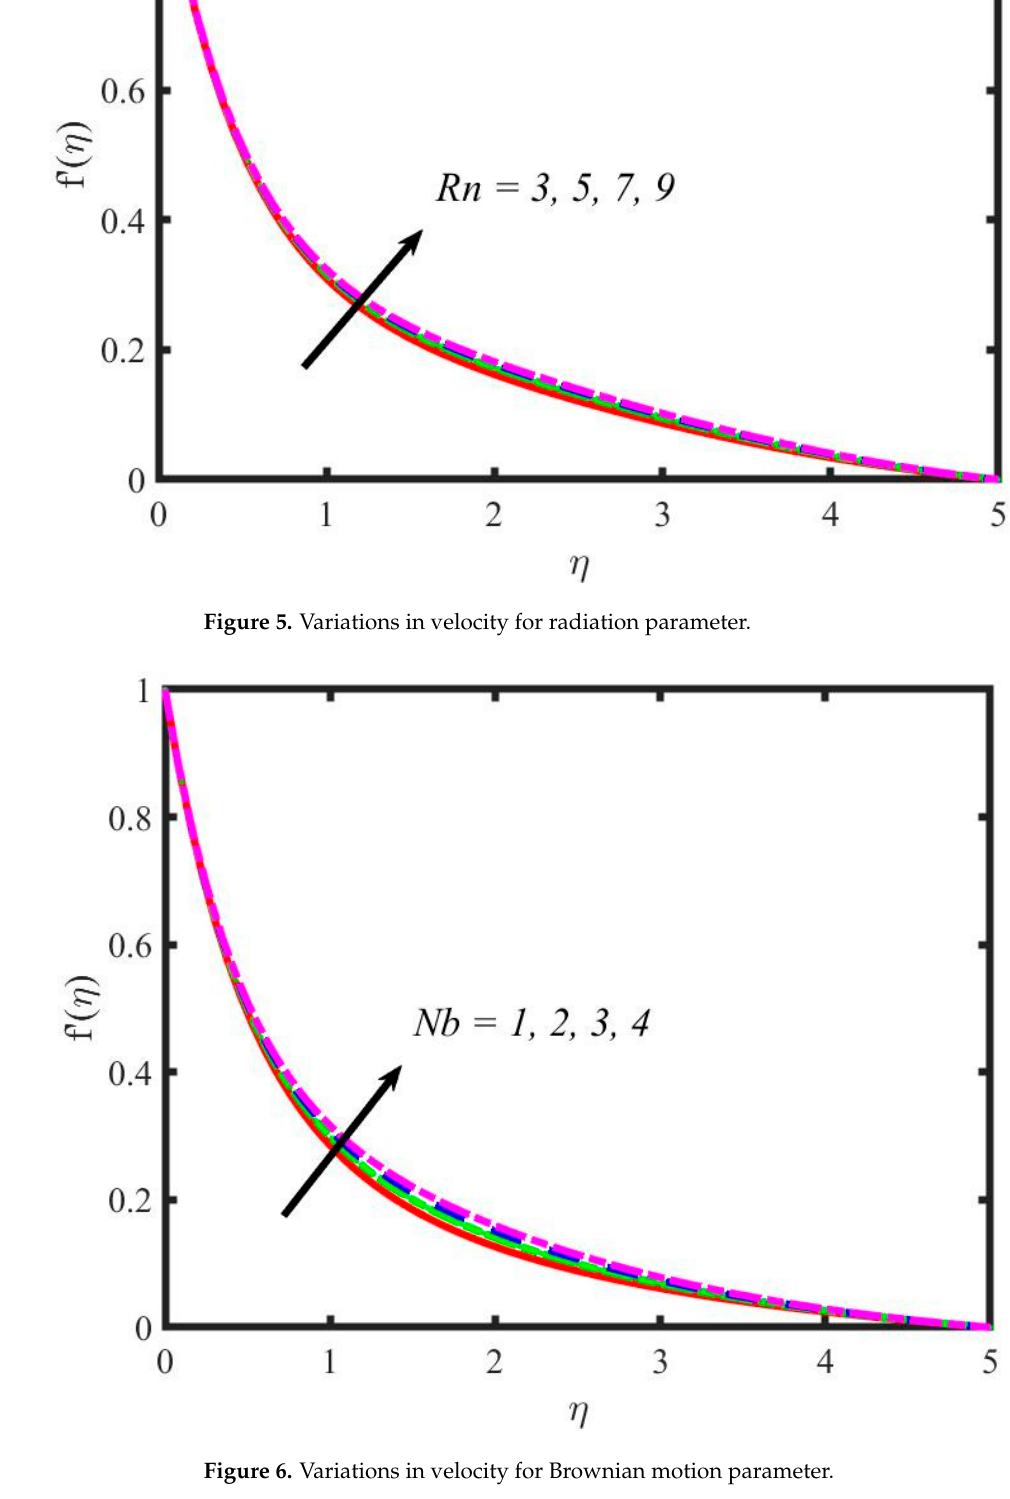
Figure 6. Variations in velocity for Brownian motion parameter.